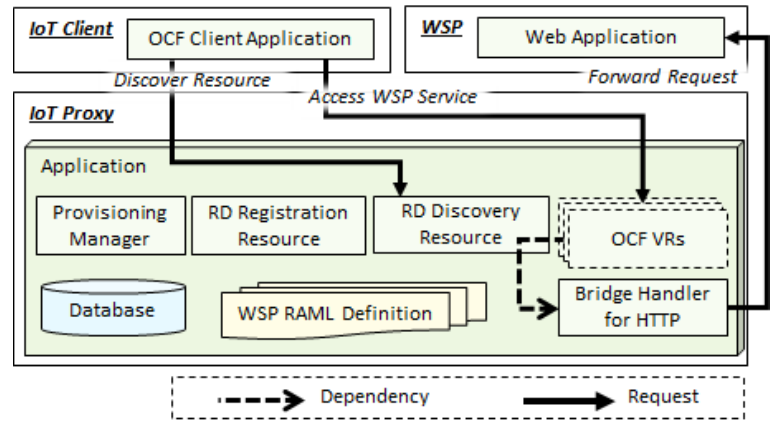
Figure 4. Proposed IoT proxy configuration based on VR.